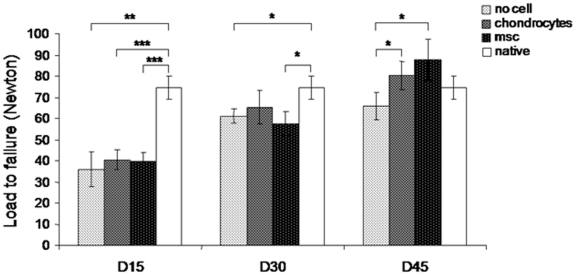
Improvement by cell therapy of the load-to-failure after repair of Achilles tendons.We determined the Load-to-failure of Achilles tendons taken from control (G1), chondrocyte- (G2) and MSC-injected (G3) rats 15, 30 and 45 days after repair and compared them to those of a native enthesis (74.4±10.9 N, white box). There was a statistically significant difference between the value for the native entheses and those for other populations at 15 days post-repair. There was a statistically significant difference between the values for the native enthesis and those of G1 and G3 30 days post-repair, and a statistically significant difference between G1 and G2 and G3, 45 days post-repair. * p<0.05, ** p<0.01 and *** p<0.001.